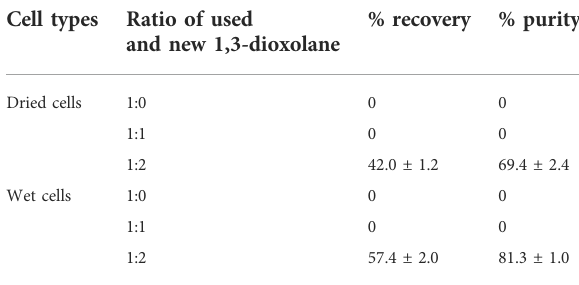
TABLE 3 Effect of reused 1,3-dioxolane on % recovery and % purity of PHB. Cell